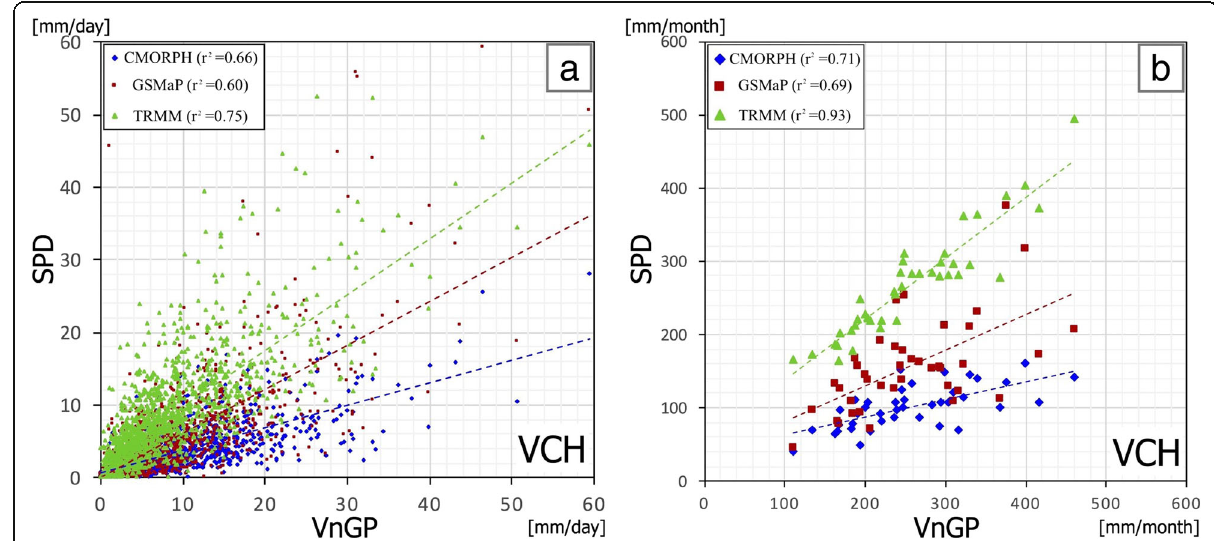
Fig. 4 Scatter plots of VnGP and SPDs (CMORPH, GSMaP, and TRMM) regional mean rainfall over the VCH for MJJA in 2001 – 2010, for a daily and b monthly values. Sample numbers are N = 1230 and 40 for each scatter plot of daily and monthly values, respectively. Correlation coefficients between each SPD and VnGP are also